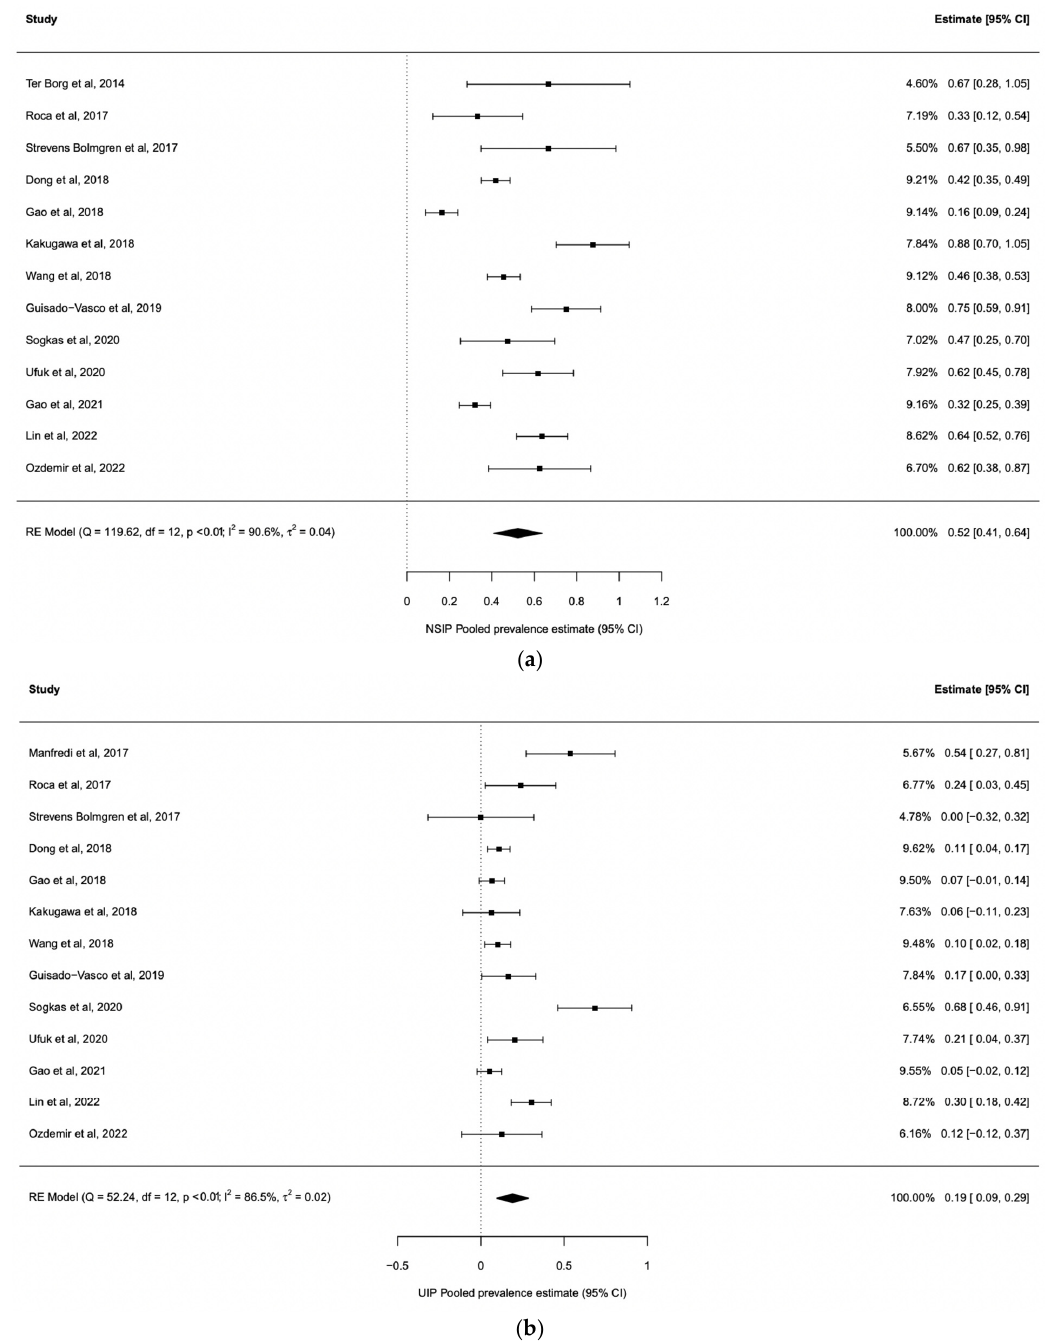
Figure 3. Forest plots depicting the pooled prevalence estimate for NSIP and UIP in ILD patients. ( a ) Forest plots depicting the pooled prevalence estimate for NSIP in ILD patients. Diamonds indicate the overall summary estimates, and width of the diamonds represents the 95% confidence interval (CI); boxes indicate the weight of individual studies in the pooled results. ( b ) Forest plots depicting the pooled prevalence estimate for UIP in ILD patients. Diamonds indicate the overall summary estimates, and width of the diamonds represents the 95% confidence interval (CI); boxes indicate the weight of individual studies in the pooled results [17–19,21–46].